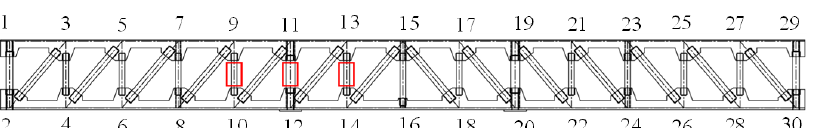
Figure 33. Schematic diagram of new damaged members.